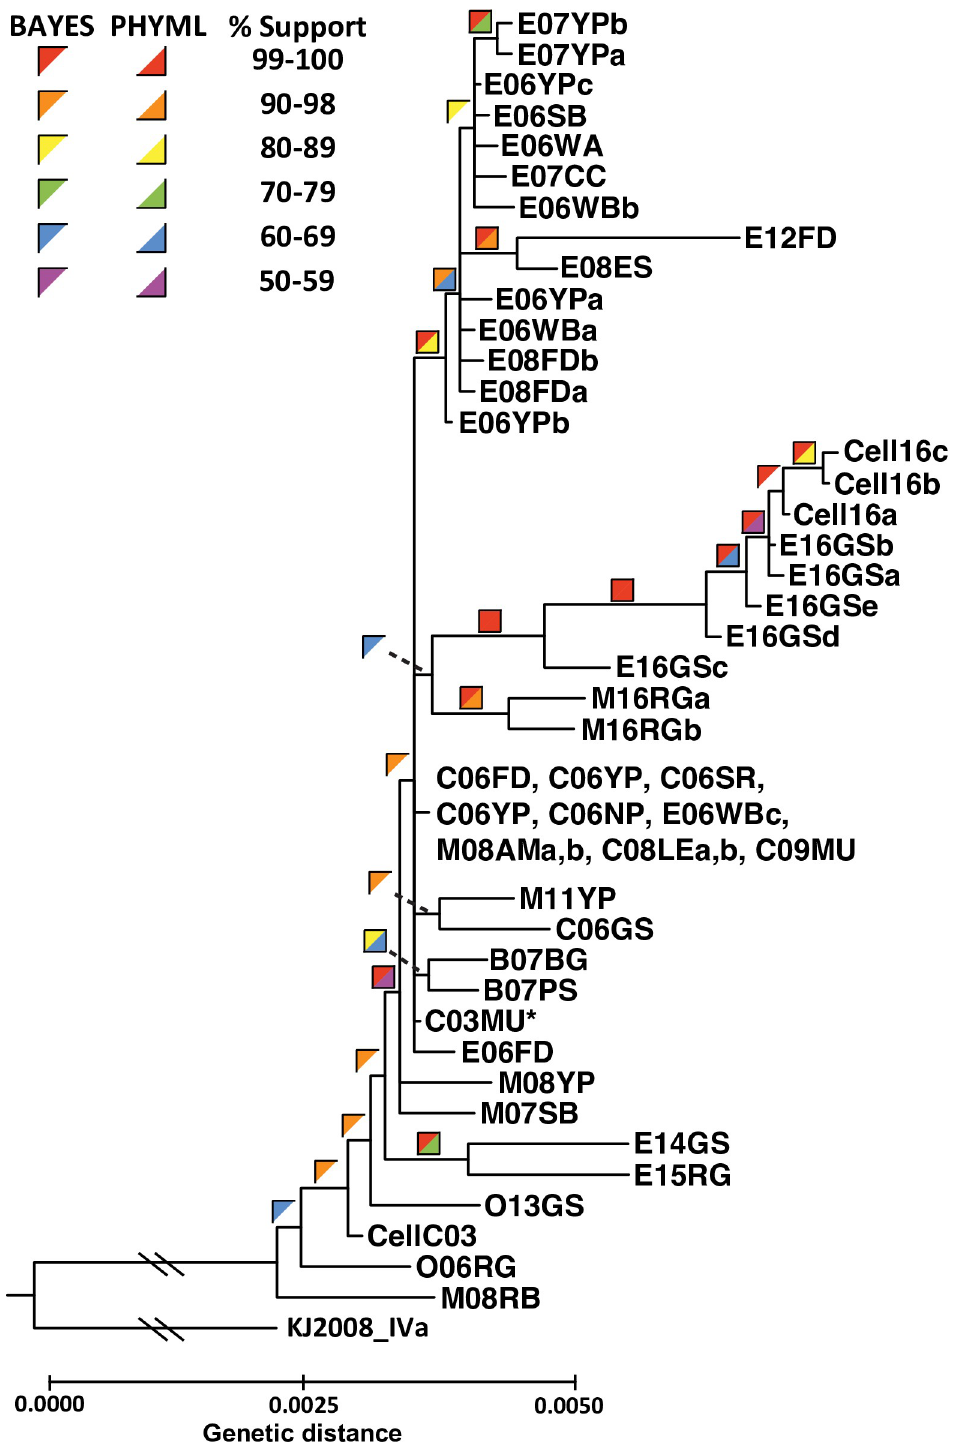
Fig 4. VHSV-IVb phylogenetic tree of aligned VHSV-IVb whole genome haplotypes, from our maximum likelihood and Bayesian analyses. Colored squares = support values, top left half = Bayesian posterior probabilities, bottom right half = 1450 bootstrap pseudoreplicates. Hashes represent cropped region for visualization. � = original VHSV-IVb isolate. Sequences from cell culture amplified isolates are labeled (E16GSa: Cell16a; E16LB:Cell16b and Cell16c). The tree is rooted to subgenogroup VHSV-IVa (GenBank: JF792424).